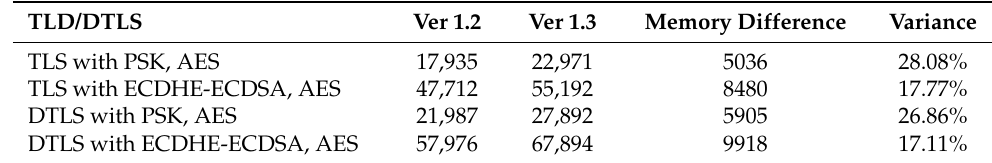
Table 5. Comparing TLS/DTLS memory footprints.